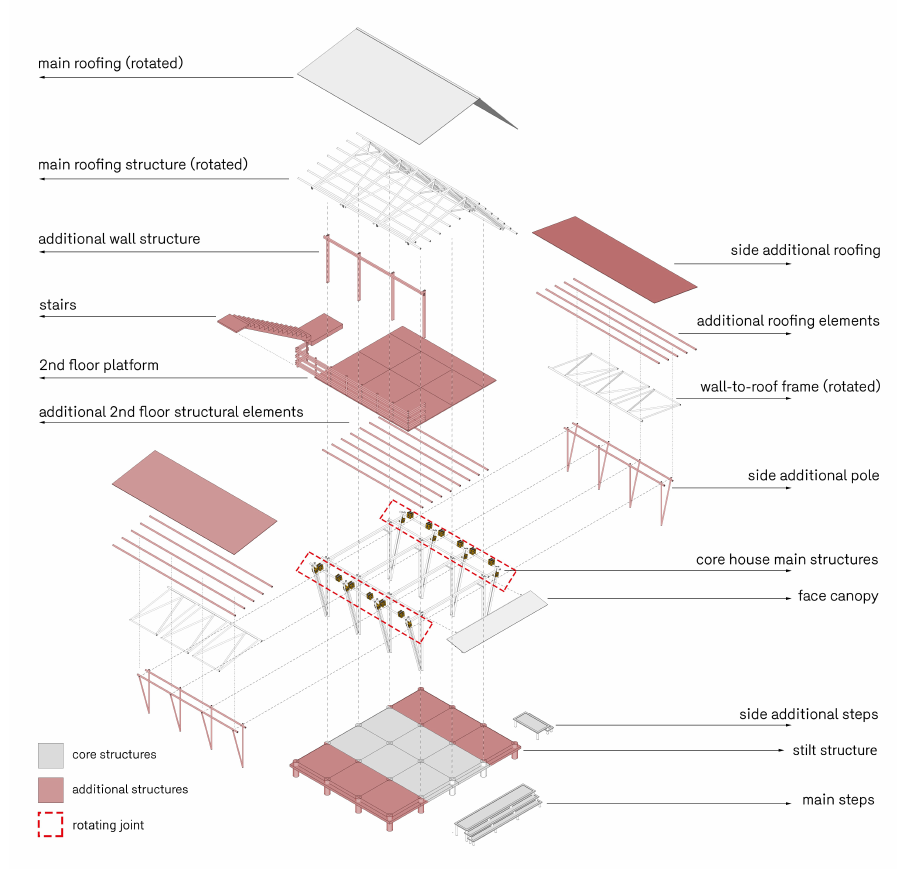
Fig. 13. Construction Elements